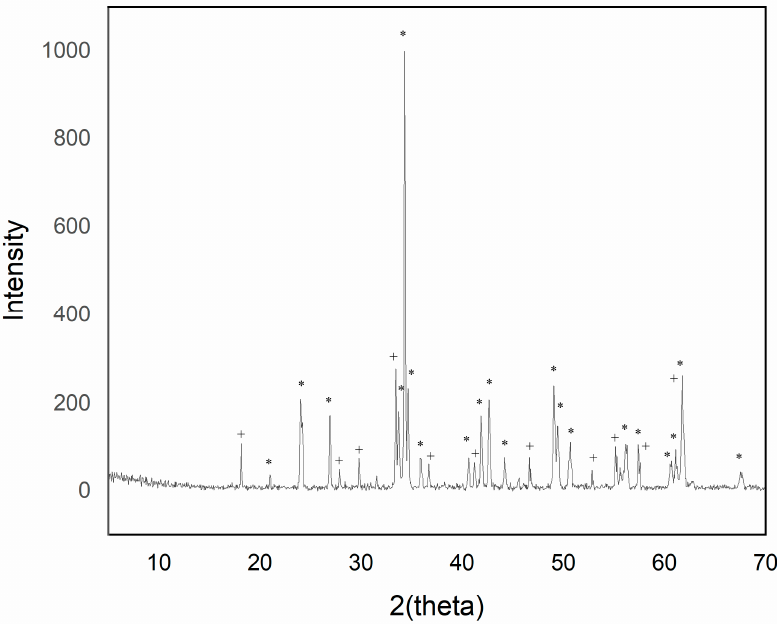
Figure 4. XRD of sample Y 0.95 AlCr 0.05 O 3 1500 °C/6 h with 5% w / w CaF 2 addition (+ garnet Y 3 Al 5 O 12 phase; * perovskite YAlO 3 phase).